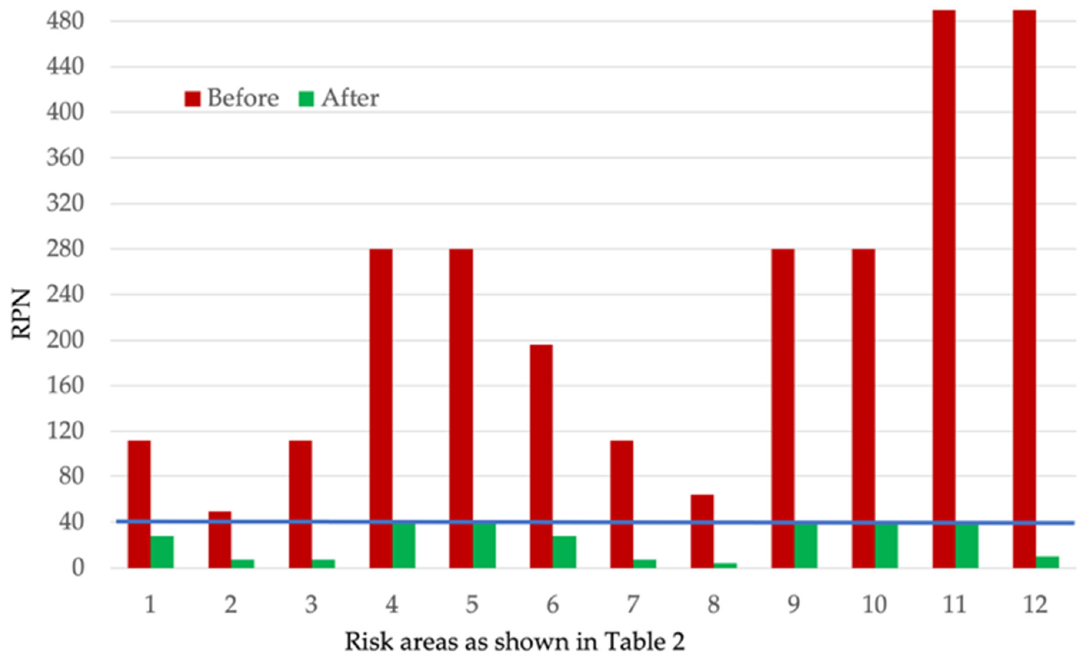
Figure 3. Risk priority number (RPN) values of the risk areas before and after control strategy implementation as described in Table 2 for the method.